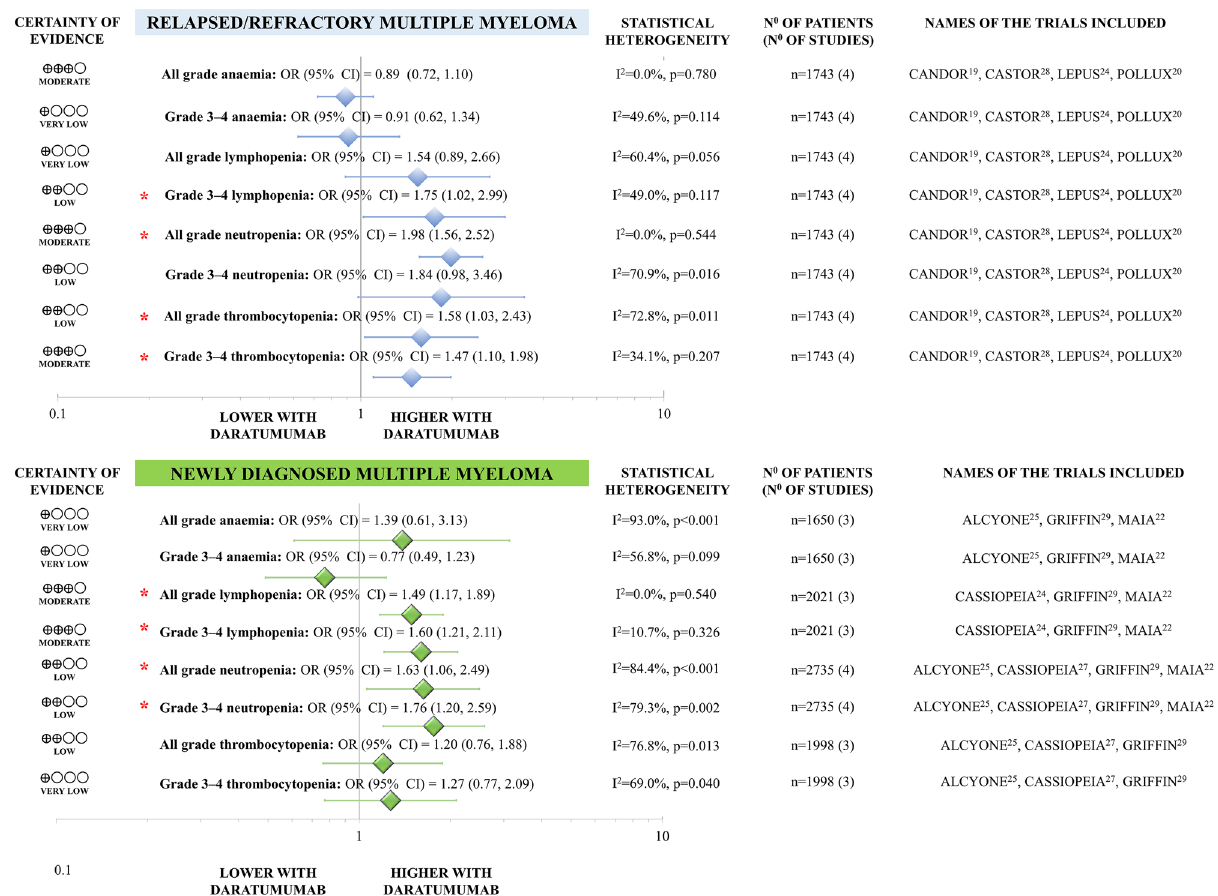
Figure 4. Haematological toxicity of daratumumab containing regimens compared to control in newly diagnosed and relapsed/refractory multiple